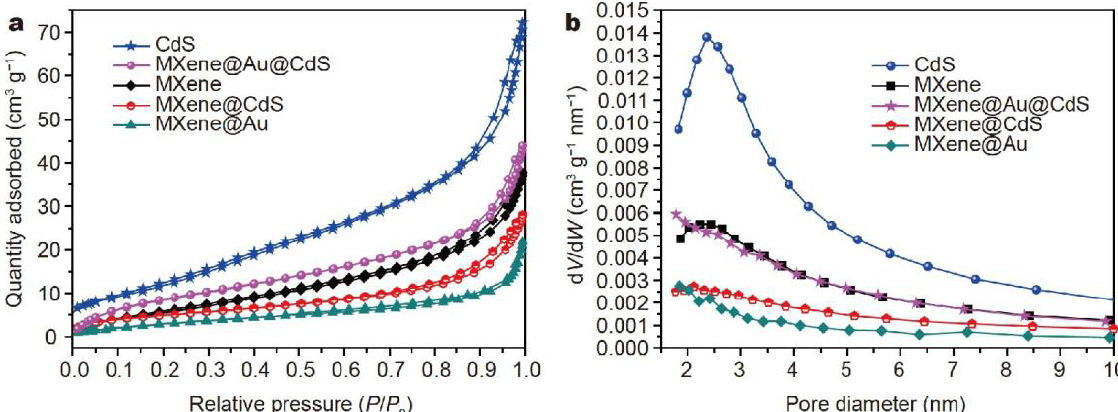
Figure 9. N 2 adsorption–desorption curves ( a ) and the pore size distributions ( b ) of MXene,